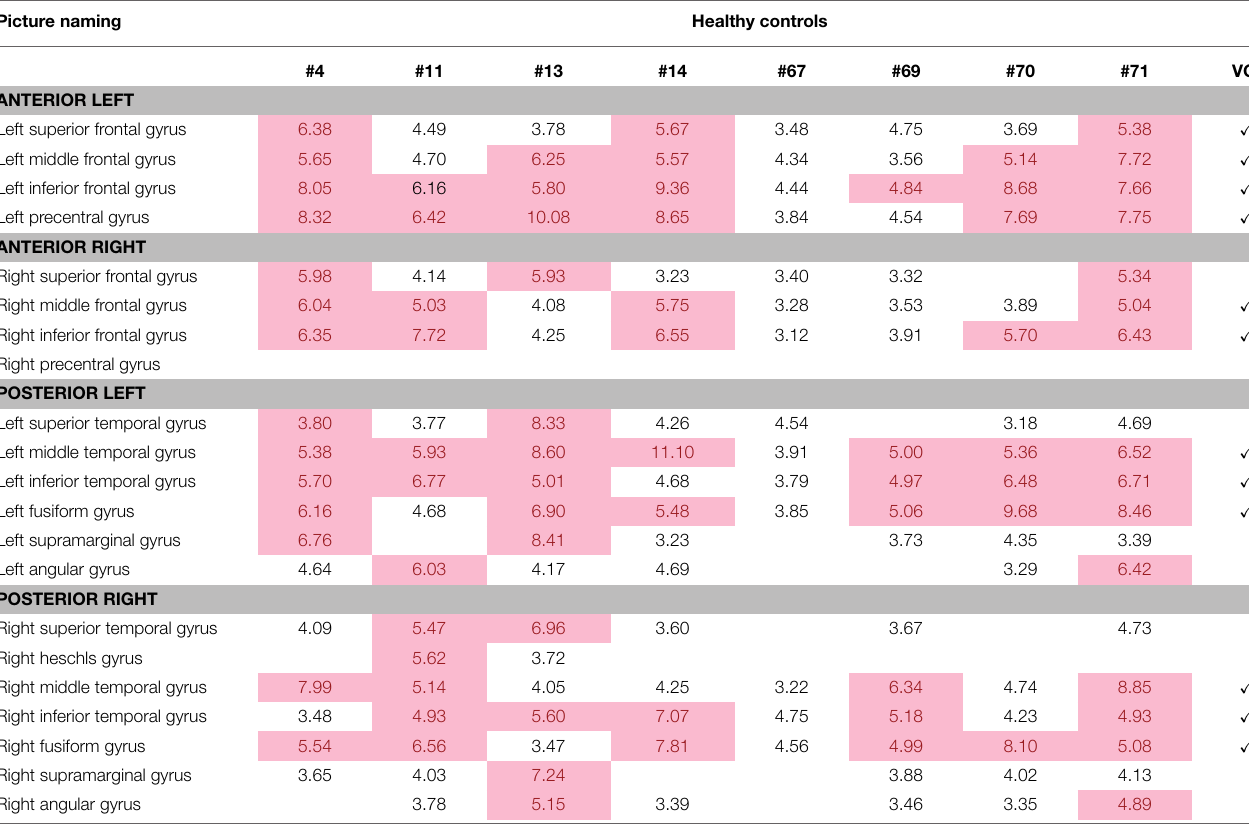
TABLE 4 | Regions of activation across healthy control participants at one time point with T -values for picture naming task. Picture